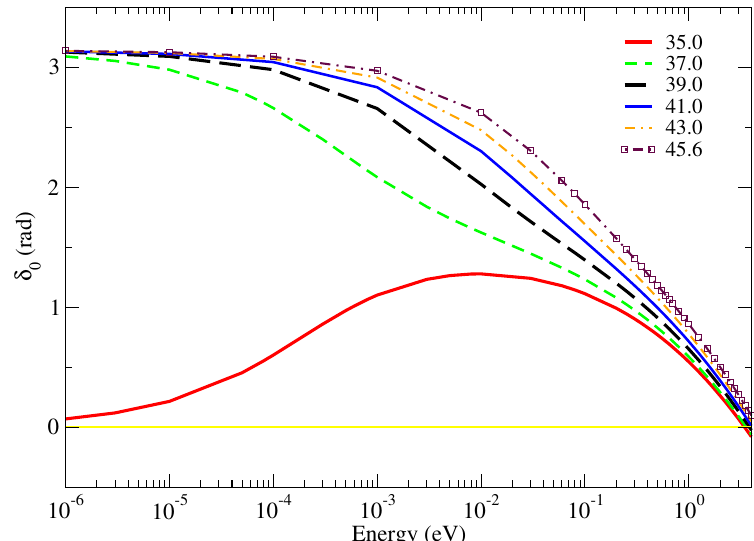
Figure 3. S-wave phase shifts for positron–Be as a function of the dipole polarizability α d . The values of α d are given in a 3 . A yellow line marks δ 0 = 0 in order to identify the suppression of the s-wave 0 cross section.